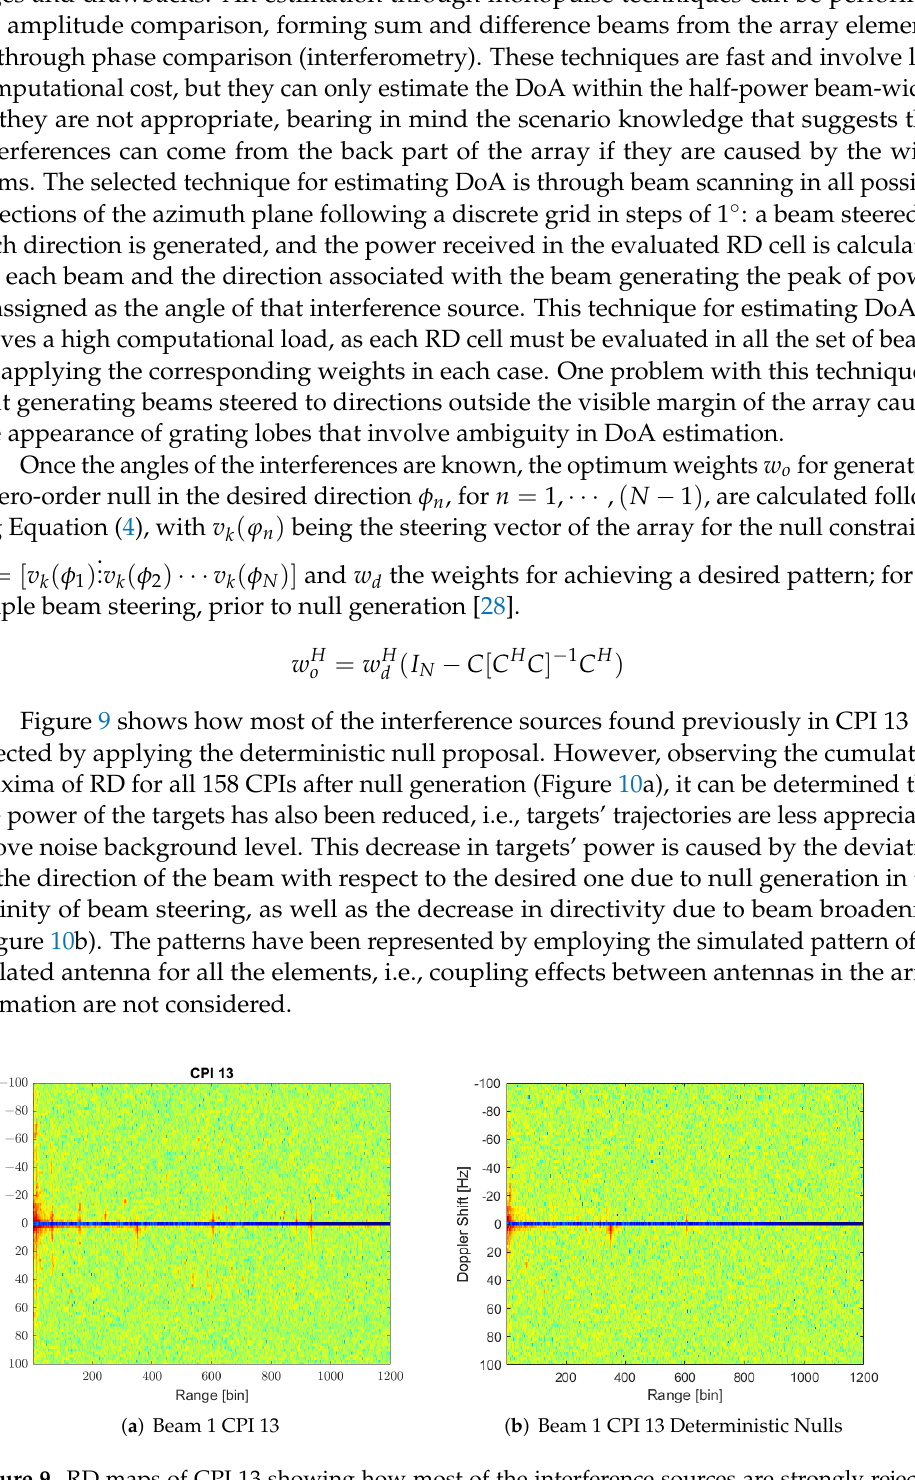
Figure 9. RD maps of CPI 13 showing how most of the interference sources are strongly rejected through deterministic nulling along the estimated